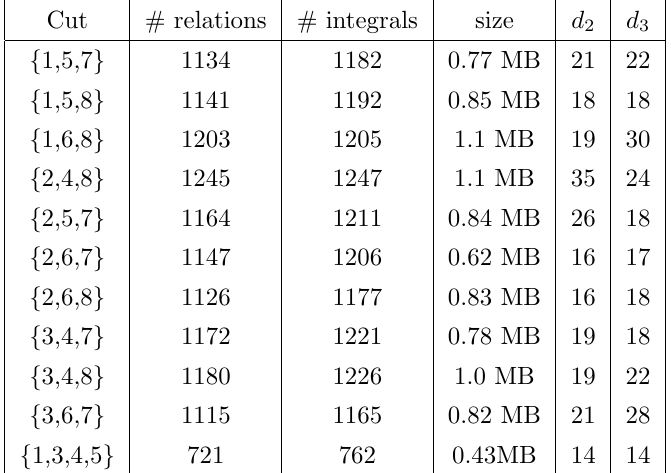
Table 2 . The IBP relations generated on each cut by the module intersection method. We used (cid:12)nite-(cid:12)eld methods to pick linearly independent and necessary IBP relations to reduce all target integrals. The size is the output (cid:12)le size on disk before reduction. The numbers d 2 and d 3 are the maximal degrees in the reduced IBP relations for c 2 and c 3 ,